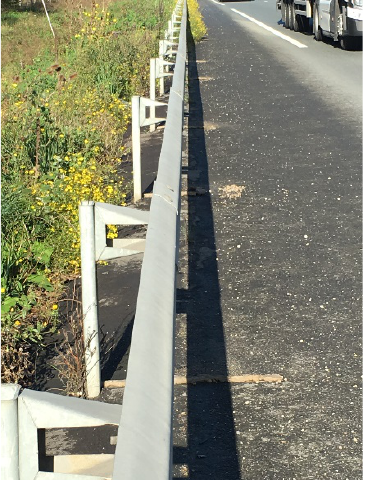
Figure A12. Galvanized steel safety barrier separating the biofiltration swale from the road surface.